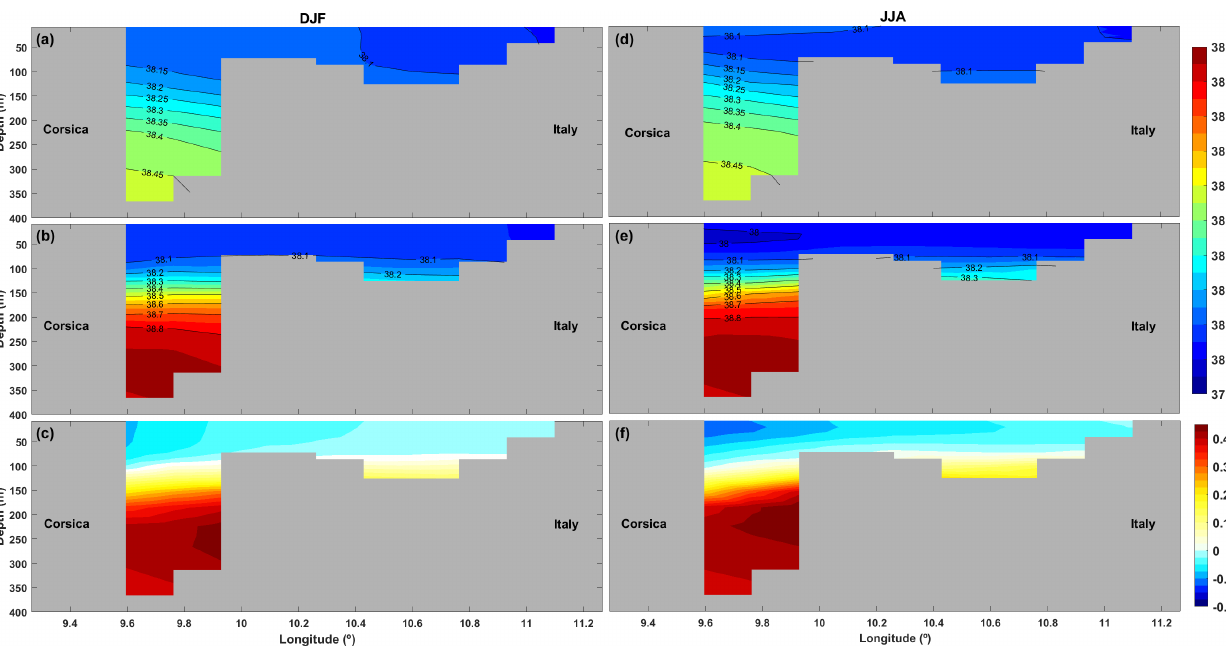
Earth Syst. Dynam., 13, 303–319, 2022